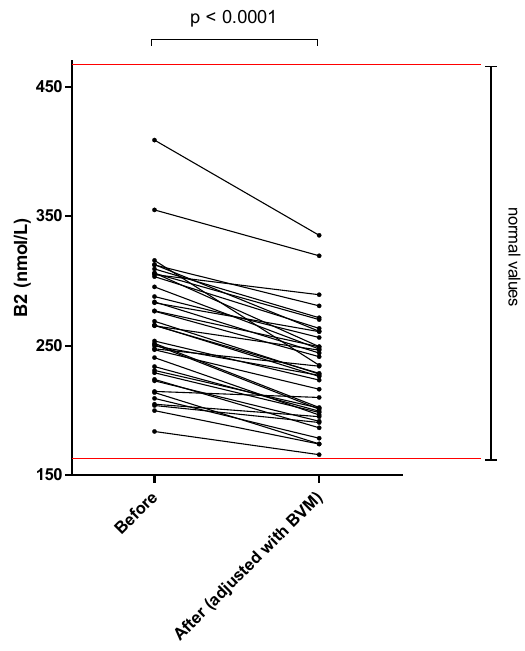
Figure 2. Vitamin B2 (FAD) blood concentration before and after one 4 h-HDF session (paired t- test).